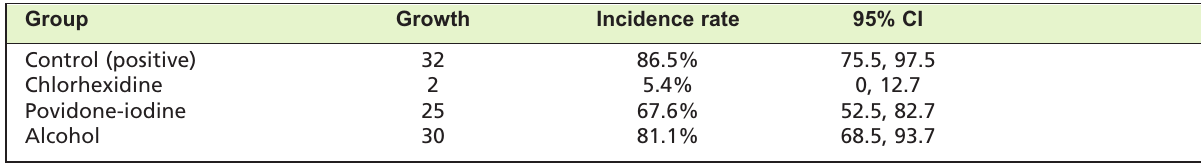
Simple linear regression analysis showing the relationship between the total bacterial count on the Table I: operation theatre floor and time of surgery Variables ß 95% CI p-value r 2 Time of surgery (mins) 0.913 0.746, 1.080 0.0001 0.854 *Bacterial count on the operation theatre floor is significantly and positively associated with time of surgery (p<0.0001) and it also explains about 85.4% of the variability (r² =0.854). In our study sample, for each minute increase in time of surgery, on average, bacterial count increase by 0.913 colonies. Incidence rate of positive culture according to groups Table II: Group Growth Incidence rate 95% CI